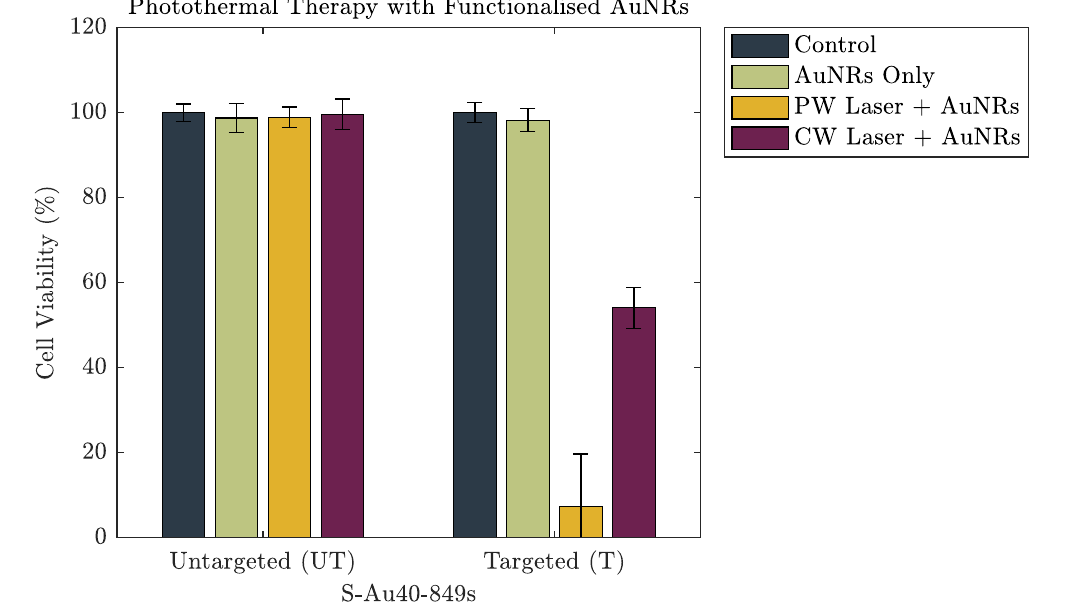
Figure 7. The cell viability of a lung cancer cell line after 24h incubation with either untargeted S-Au40-849s or targeted